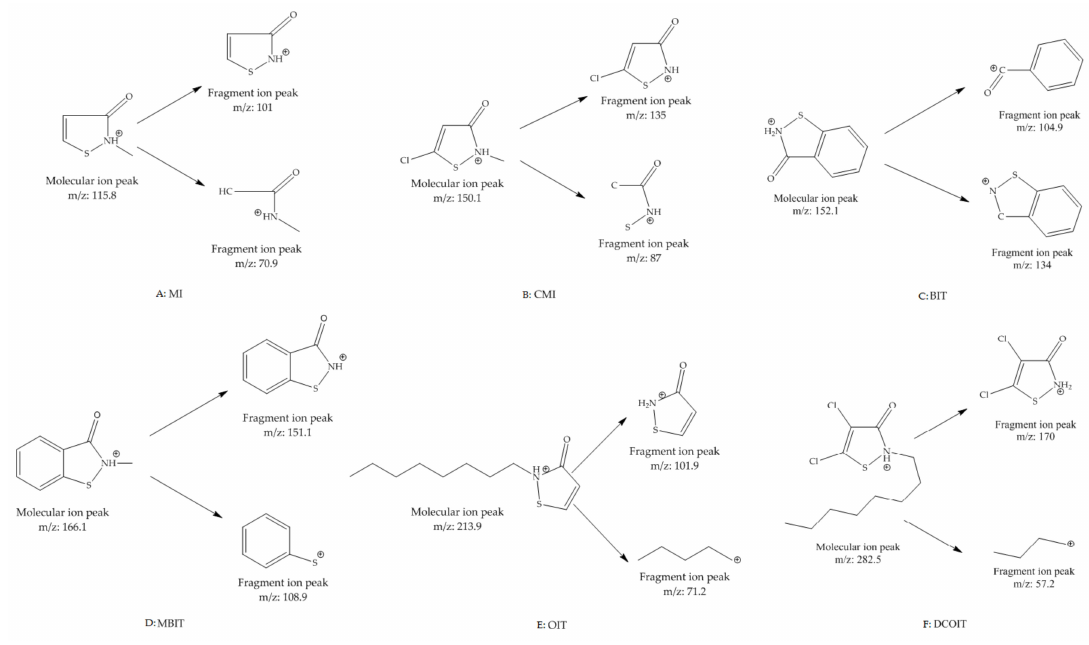
Figure 5. The proposed fragmentation pattern of